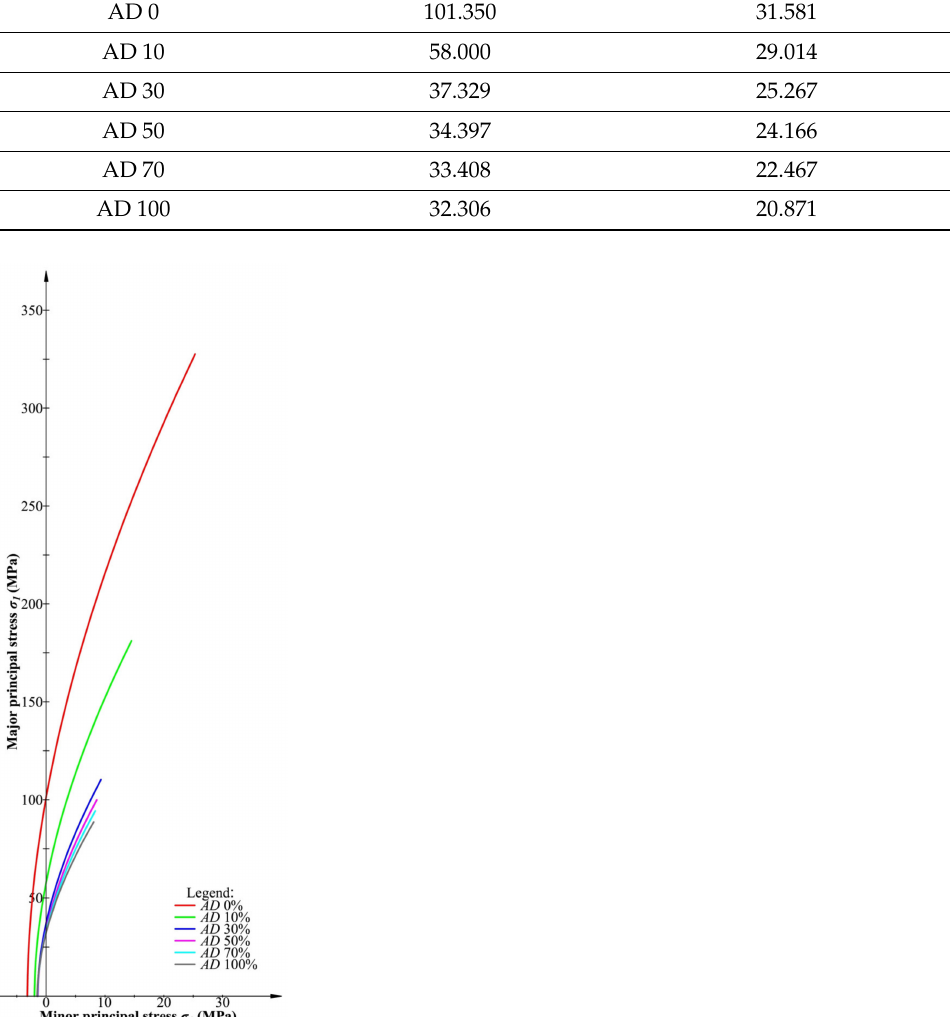
Figure 10. Relationship between maximum and minimum stress for different participation of